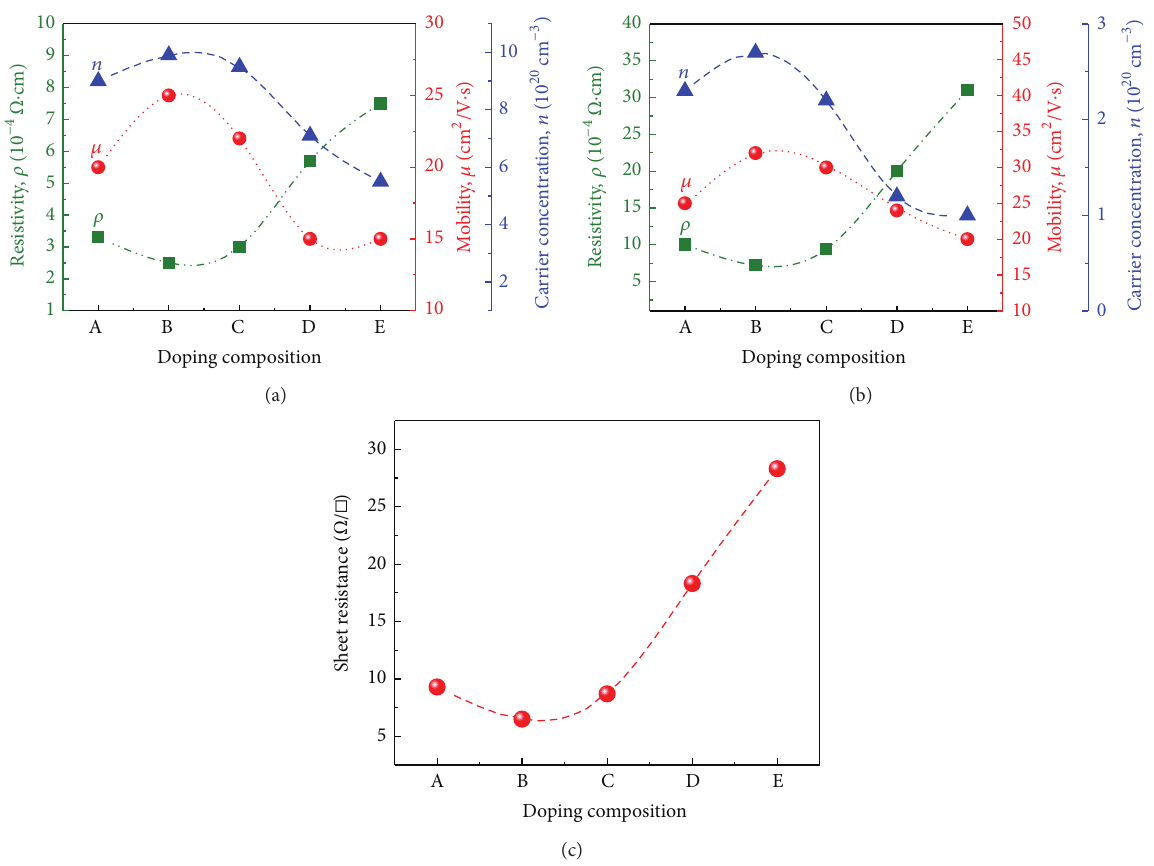
Figure 2: Carrier concentration, mobility, and resistivity of (a) as-deposited samples and (b) postannealed samples and (c) sheet resistances of postannealed samples with various In and Ga contents in targets.